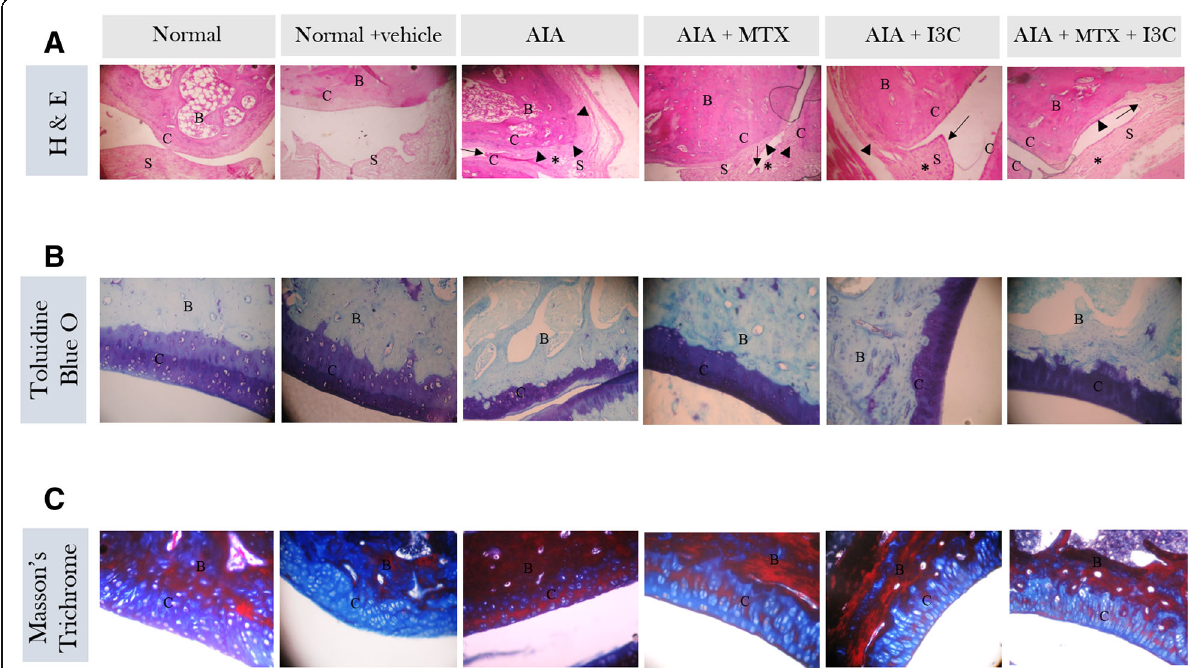
Fig. 4 Studying effect of I3C on the tibiotarsal joint in the ankle at a histological level. a H&E staining was done to study cellular infiltration (*), synovial hyperplasia ( ↑ ), pannus formation ( ► ). Arthritic non-treated model group reveals severe pathological changes while the treated groups reveal reduced pathological changes. b, c Toluidine Blue O was used to qualitatively assess the proteoglycan content in the cartilage while Masson ’ s Trichrome was used to qualitatively assess the presence of calcified cartilage. Toluidine Blue staining of arthritic non-treated model group reveal the presence of locally extensive areas of superficial matrix pallor accompanied by degeneration of chondrocytes while Masson ’ s Trichrome stain reveal substantial amounts of red color staining in the non-calcified cartilage region (superficial layer of cartilage) signifying the heavy presence of calcified cartilage. All treated groups reveal less damage exerted on the cartilage. B: bone, C: cartilage, S: synovium. Photomicrographs (A) at ×40; (B, C) at